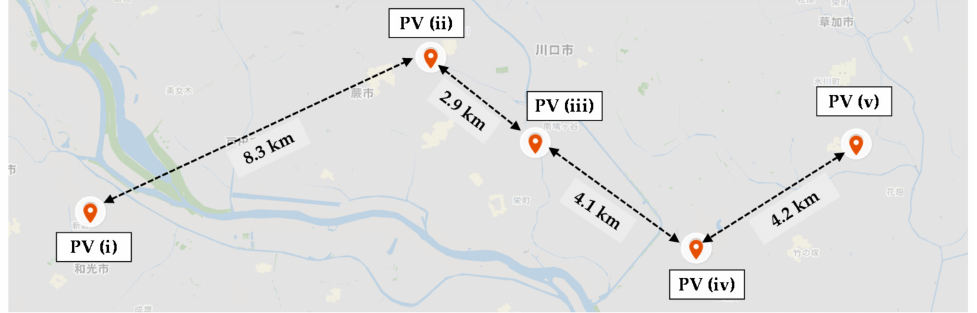
Figure 6. Location of the PV systems to be forecasted in